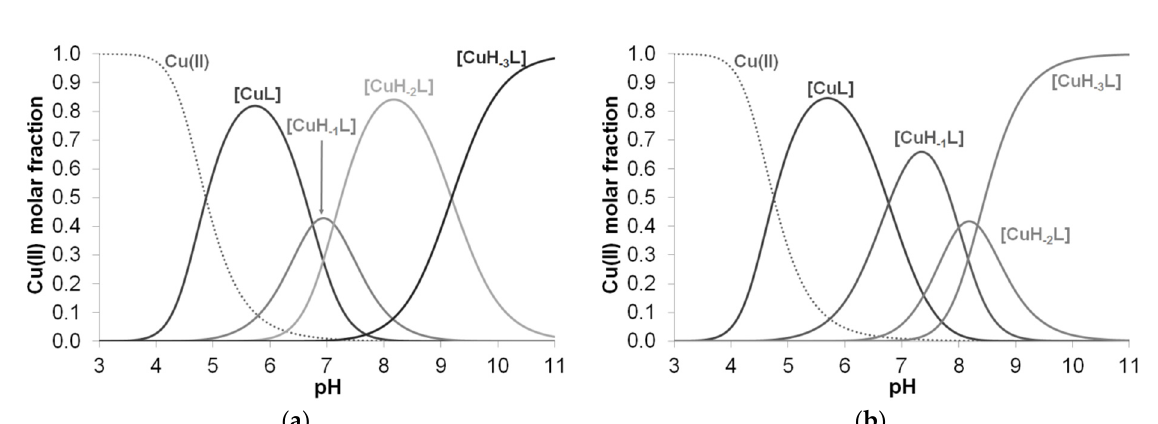
Figure A1. Distribution curves of complexes formed in the equimolar solution of Cu(II)-Ac-HDAH- NH 2 ( a ) and Cu(II)-Ac-HADH-NH 2 ( b ) (c L = c M = 2 mM).